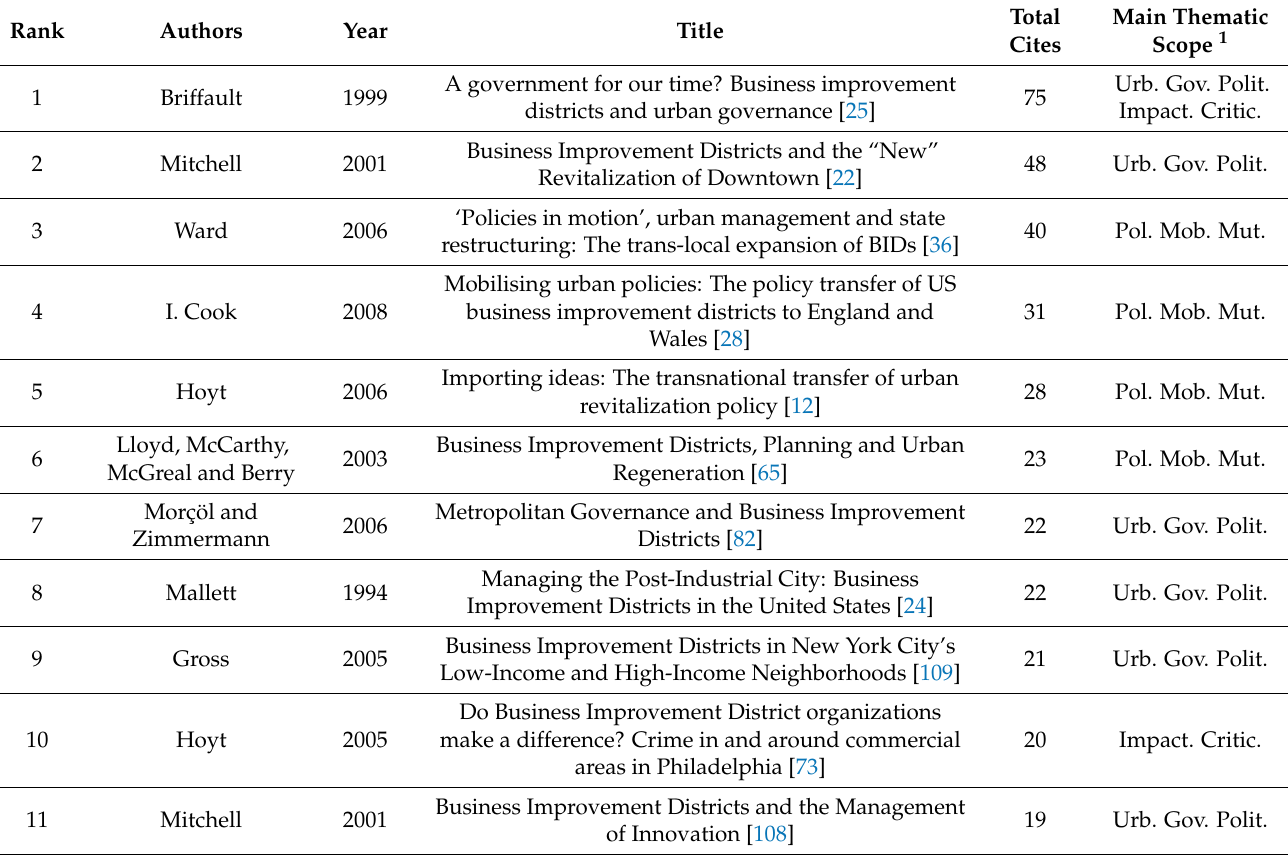
Table 6. Most relevant local-cited documents published on BIDs,